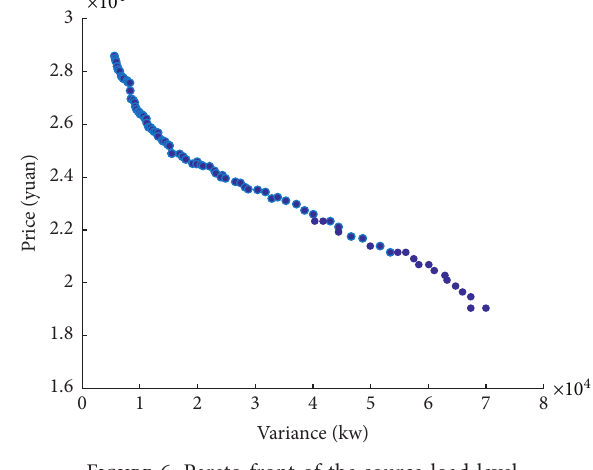
Figure 6: Pareto front of the source-load level.